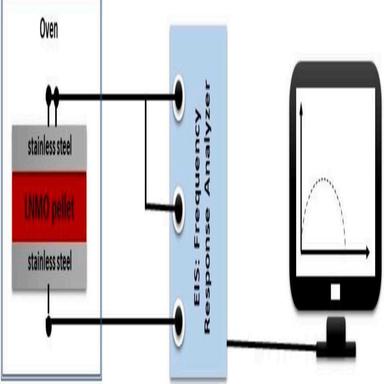
Schematic diagram of the testing method for measuring the electronic conductivity of LNMO.